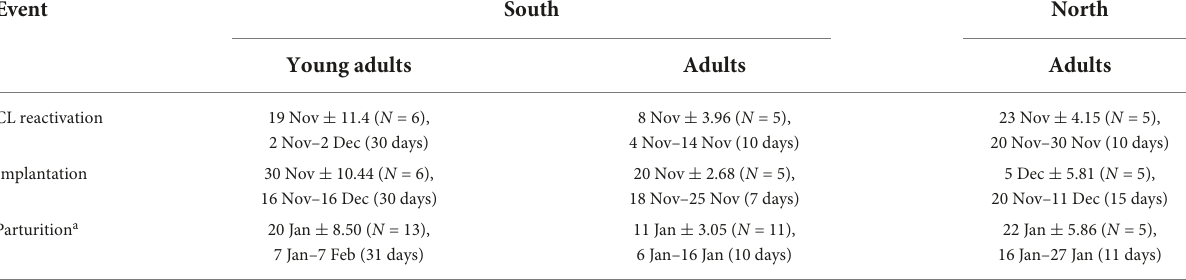
TABLE 1 Reproductive events of young adult and adult female brown bears in two study areas in Sweden,